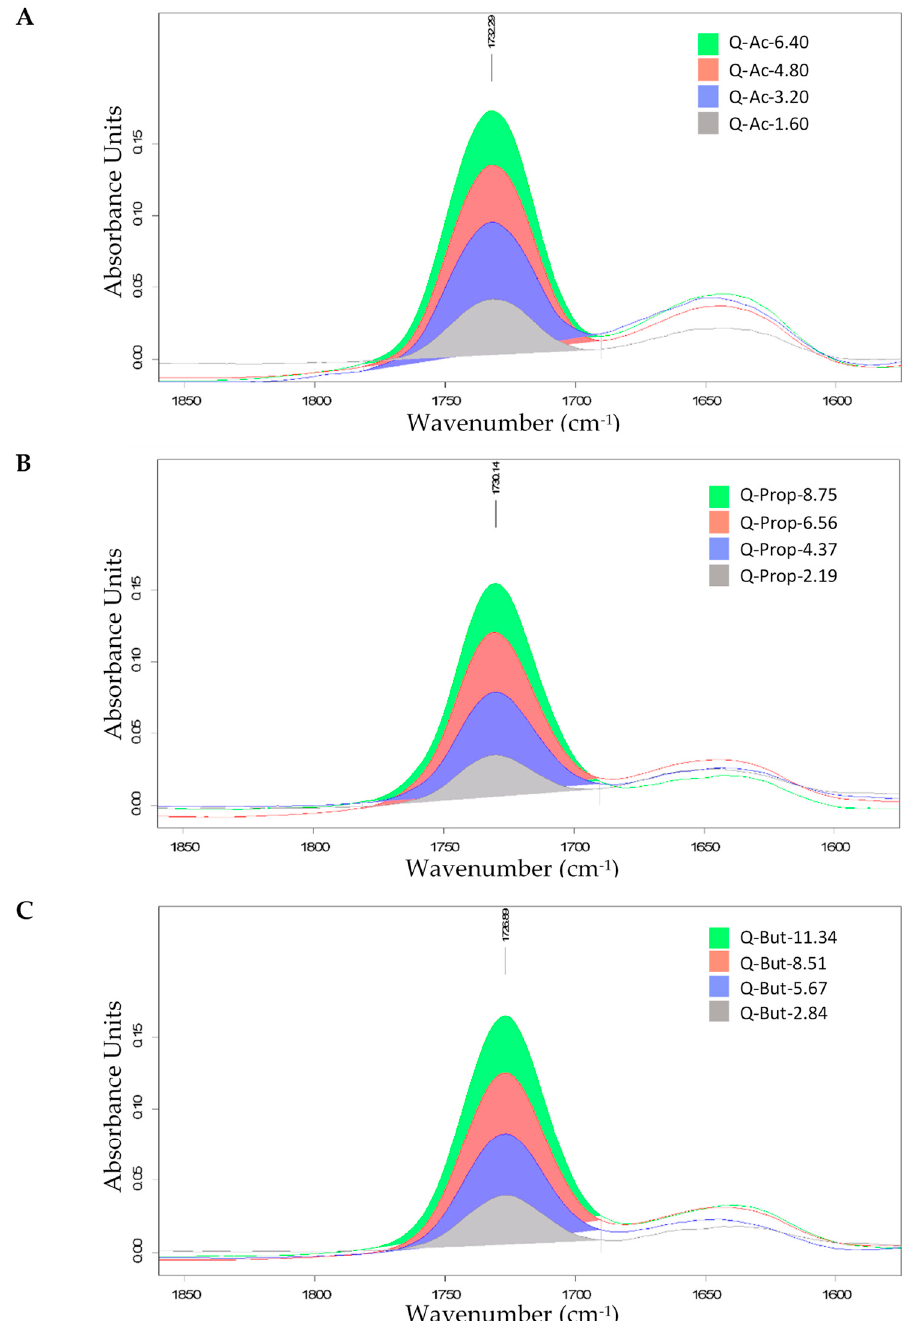
Figure 3. FTIR spectra with peak focused on carbonyl stretching vibration (C=O) band at integral (1781–1690 cm − 1 ) acetylated, propionylated, and butyrylated quinoa starches at different levels of modification; ( A ) acetylated quinoa (Q-Ac), ( B ) propionylated quinoa (Q-Prop), and ( C ) butyrylated quinoa (Q-But).